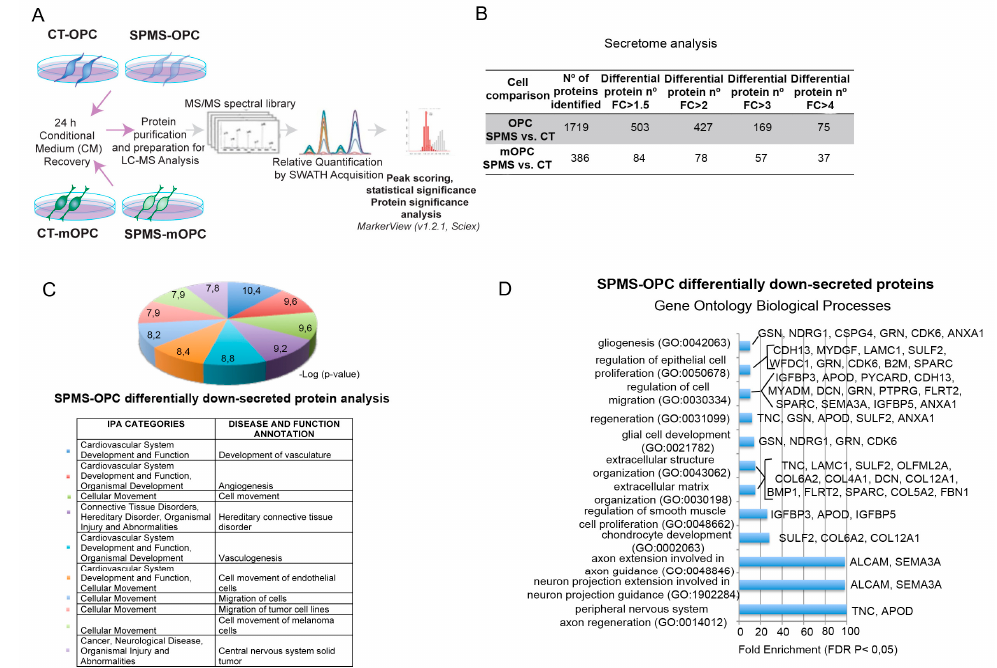
Figure 4. Analysis of proteins di ff erentially secreted by SPMS-derived OPC-like cells. ( A ) Schematic protocol for supernatant recovery and secretome analysis. SPMS- and CT-derived early OPC-like and mature OPC (mOPC) cells were cultured in fasting media (see methods) for 24 h. Incubated media were recovered, and proteins were purified, prepared for liquid chromatography–mass spectrometry (LC-MS), and used to create a MS / MS spectral library using a SWATH-MS acquisition method for relative quantification. Data analysis was performed using the add-in for PeakView Software, and for testing di ff erential protein abundance between the selected groups, MarkerView (v1.2.1, Sciex) was used. ( B ) Secretome analysis of SPMS and CT-derived early OPC-like and mOPC cells. Number of proteins di ff erentially represented ( p < 0.05) between SPMS and CT samples with a folding change (FC), over 1.5, 2, 3, or 4. ( C , D ). Identification of the top represented significant disease and function categories using Ingenuity ® Pathway Analysis (IPA ® ) ( C ) or annotated Gene Ontology (GO) Biological Processes ( D ) based on downsecreted proteins in SPMS-derived early OPC-like cells. SWATH-Mass Spectrometry (SWATH-MS) analysis allowed the relative quantification